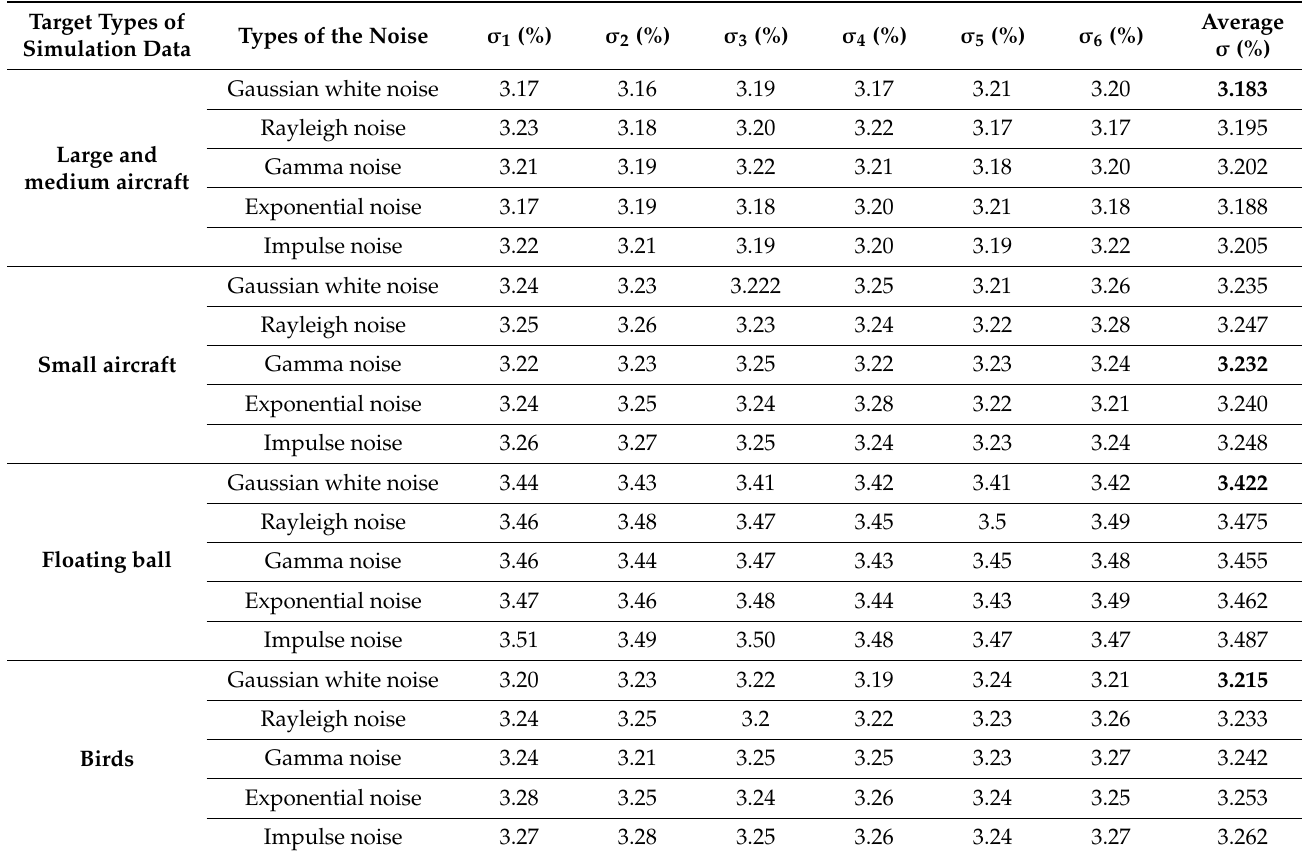
Table 1. The standard deviations of the simulation data of the four kinds of targets into which the five mentioned types of noise are added.